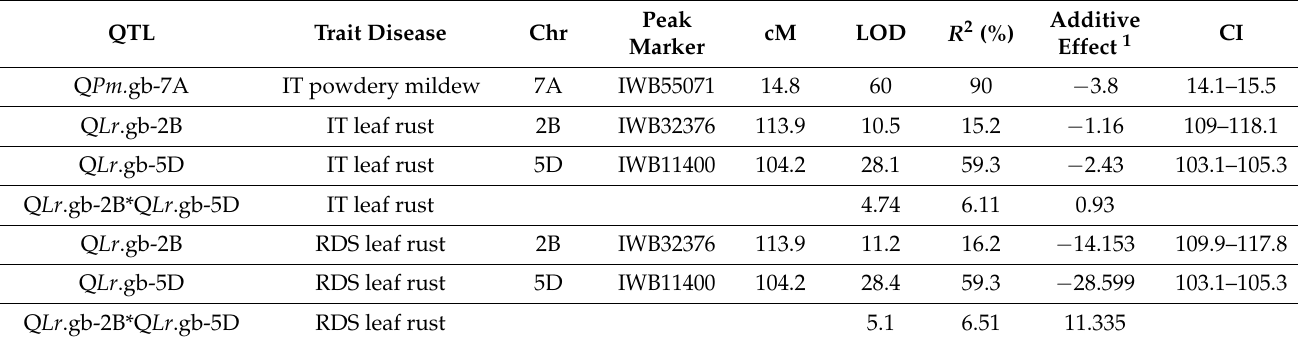
Table 4. QTLs and their interactions detected in the Victo × Spada segregating population for powdery mildew and leaf rust resistance. Chromosomes (Chr), peak marker, LOD scores, percentages of phenotypic variance explained ( R 2 ), estimated additive effects, and the confidence interval (CI) were also provided.